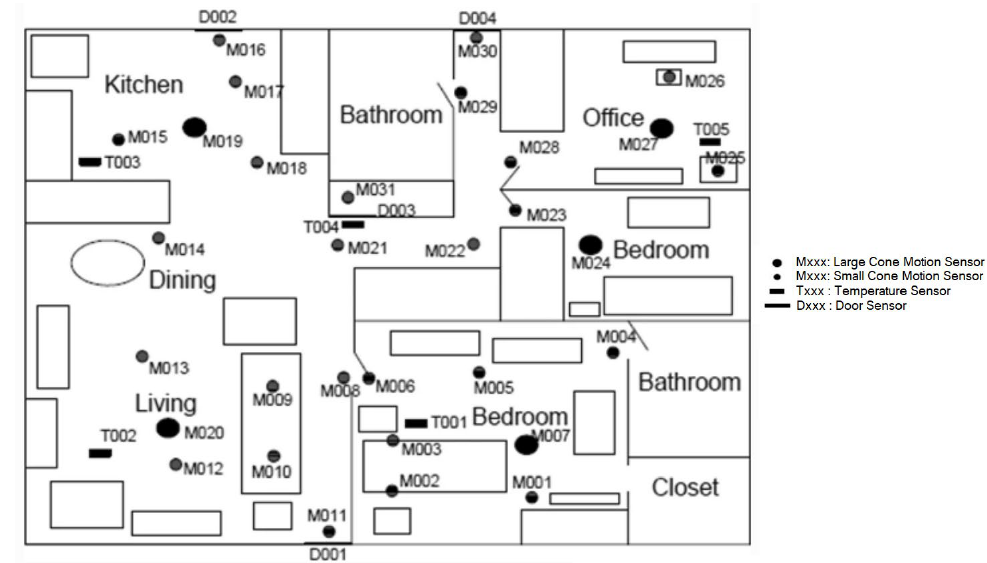
Figure 8. Floor plans of Kasteren houses; red boxes represent the sensors [47]. ( a ) House A. ( b )